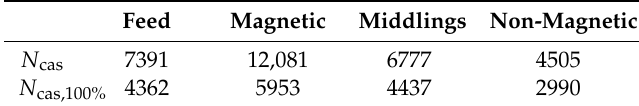
Table 8. Number of particles ( N cas : particles containing cassiterite; N cas , 100% : particles with 100% volume liberated cassiterite).